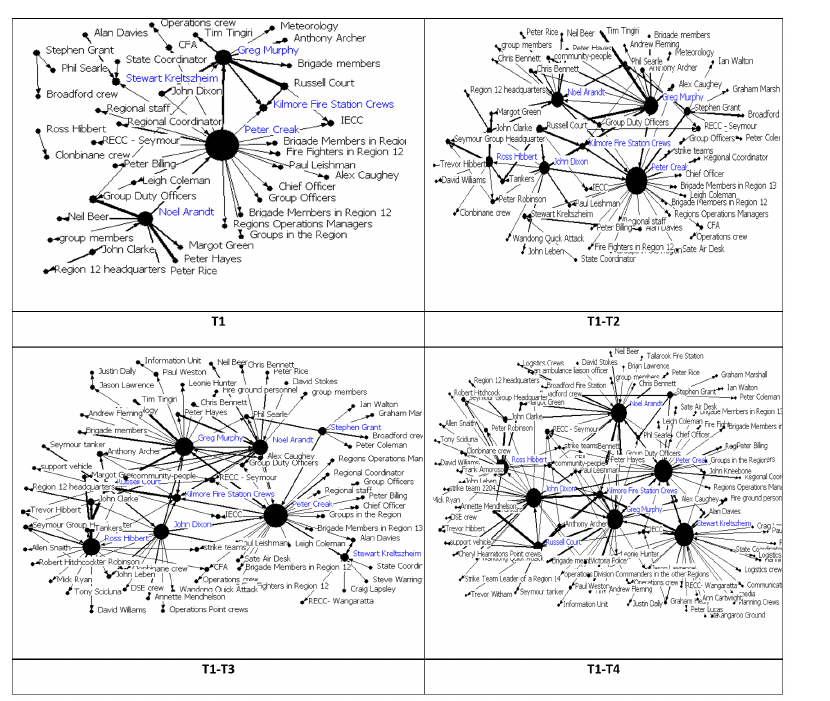
Fig 5. Kilmore East response network (size of the nodes reflects nodes’ degree centrality).